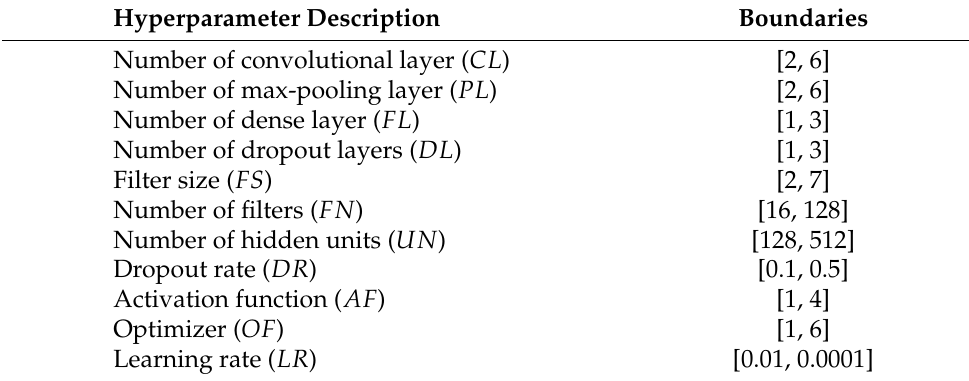
Table 7. List of CNN hyper-parameters along with search space